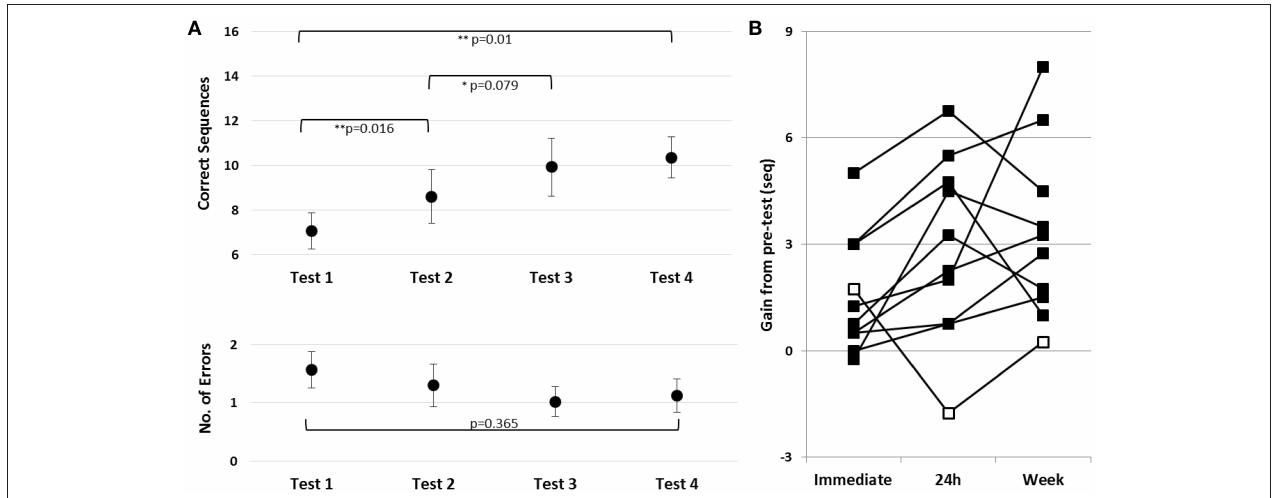
FIGURE 3 | Effects of a single training session in the Trained TBI group. (A) Time-course of improvement in performance. Upper panel–speed; group average of the absolute number of correct sequences at each of the four trials of the performance tests (pre-training, post-, 24 h- and week- post-training). Lower panel–accuracy; Respective errors–group average of the number of incorrect sequences performed at each test. Bars–SE of the mean. (B) Absolute individual gains ( 1 ) relative to pre-training baseline performance, calculated as [Immediate = (Test 2–Test 1); 24h = (Test 3–Test 1); Week = (Test 4–Test 1)]. Open square–case patient with a decrease in performance at Test 3 (negative gains) note recovery a week later, at Test 4.